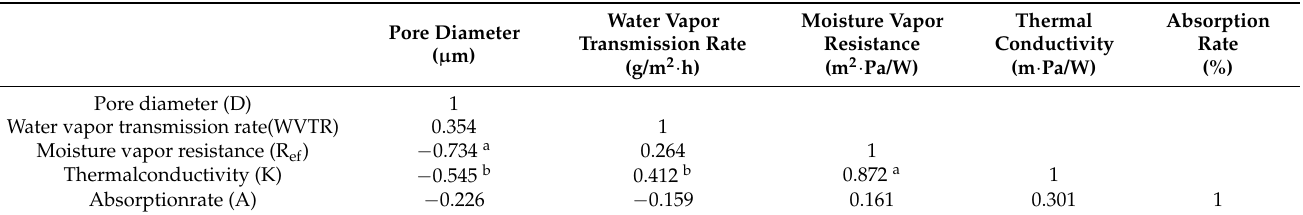
Table 7. Correlation coefficient between each parameter of the wear comfort characteristics of the fabrics.